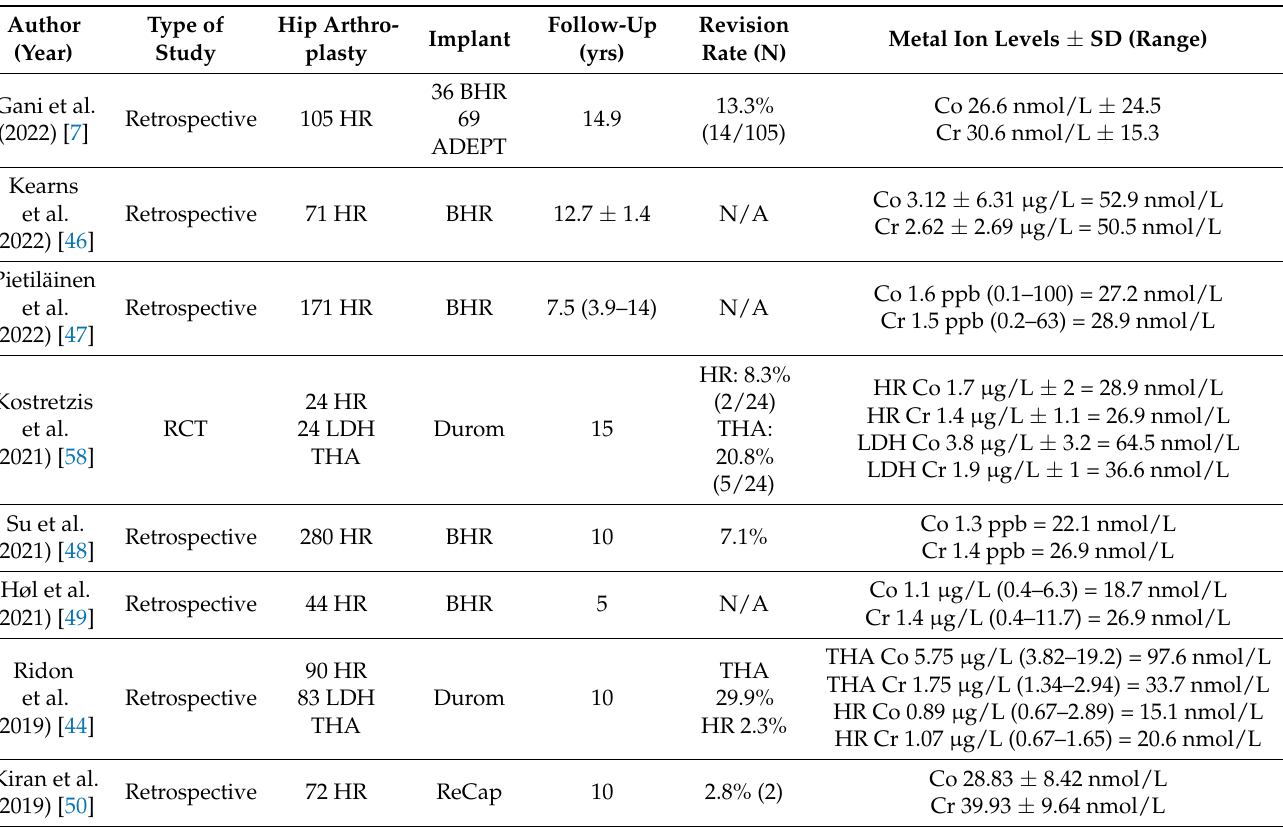
Table 6. Ion Levels and Revision Rates at Mid-to-Longterm